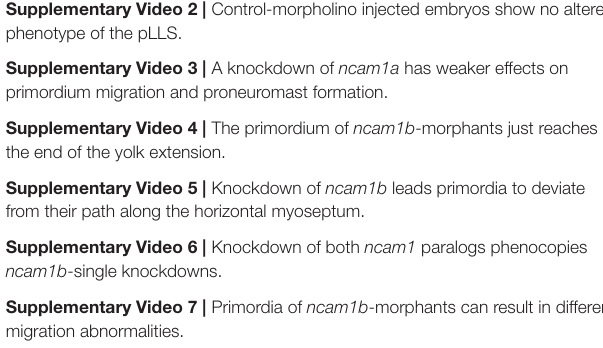
CHD-NCAM1 sequence. (A–C) Sequences of Ncam1 homologs. (D) Sequences of Fgfr1 homologs. (A) The FGF receptor activation motif (FRM) is located in the